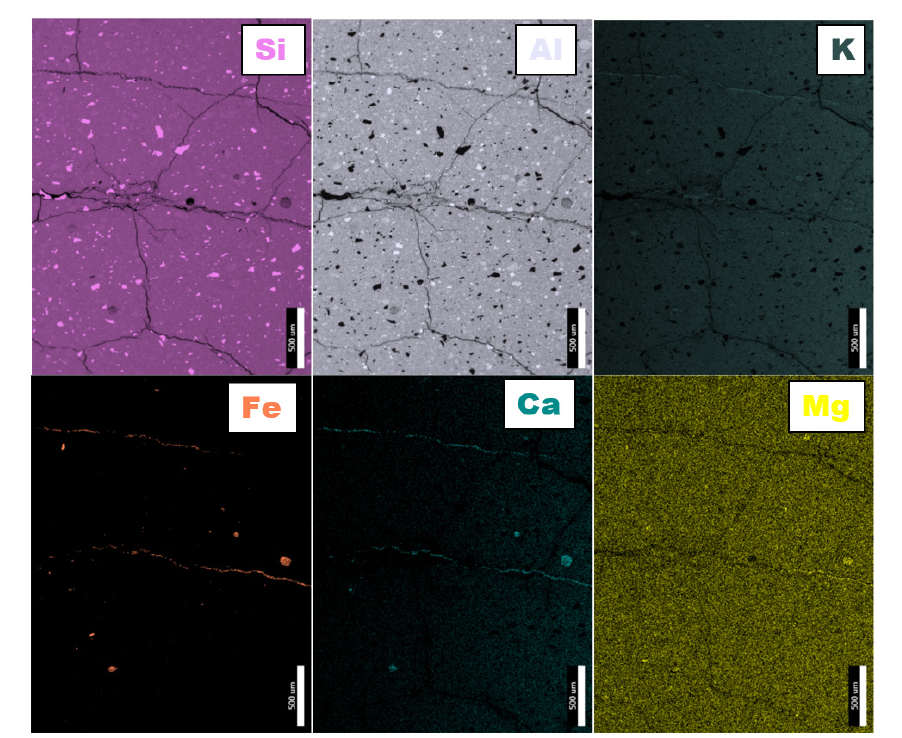
Figure 8. Separation of individual elemental maps taken from the middle (stack) image of the Fig 7.